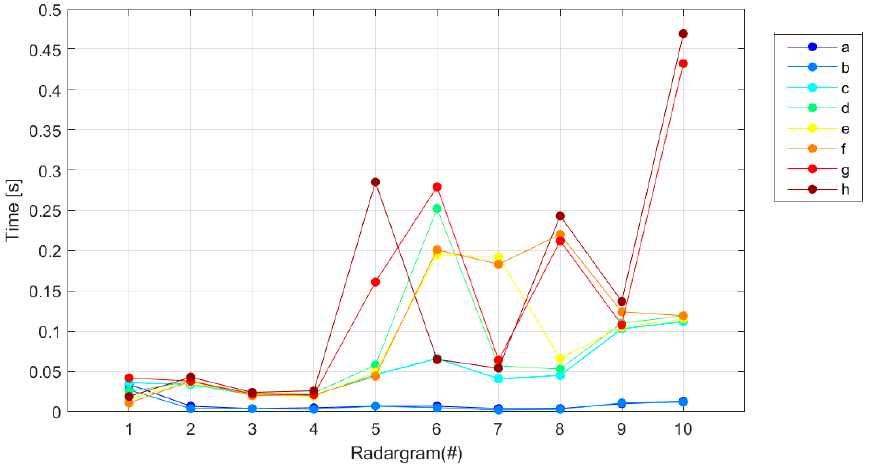
Figure 11. Processing time for Canny-edge detection plus subsequent identification of unnecessary edge pixels, using the various search zones of Figure 4.